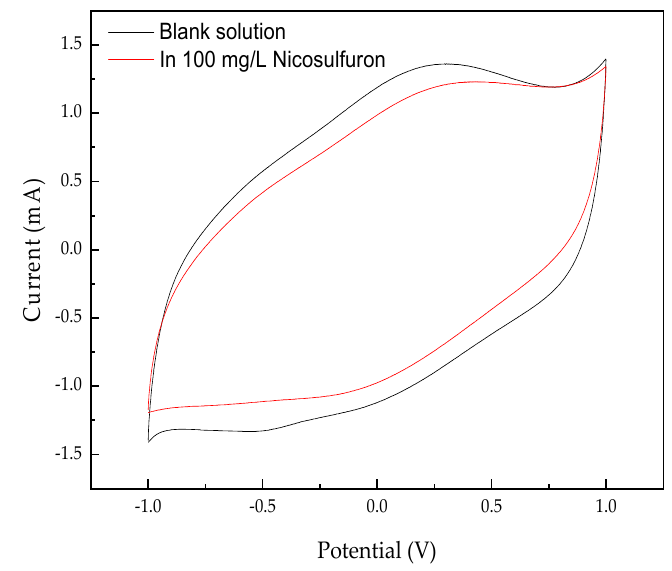
Figure 10. CV curves of the Ti/Ta 2 O 5 -IrO 2 electrode in the absence and in the presence of nicosulfuron. The voltammetric response on the Ti/Ta 2 O 5 -IrO 2 electrode at different scan rates is shown in